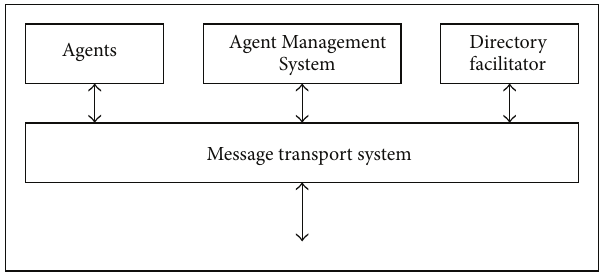
Figure 3: Architecture of multiagent